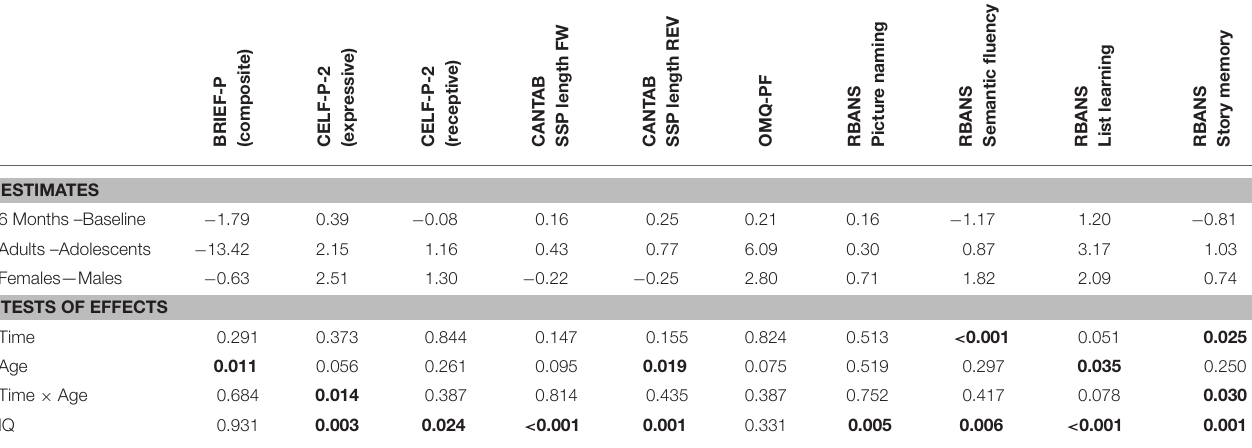
TABLE 5 | Estimates of differences for each assessment and influence of Time, Age, and IQ ( p -values as from MMRM analysis).